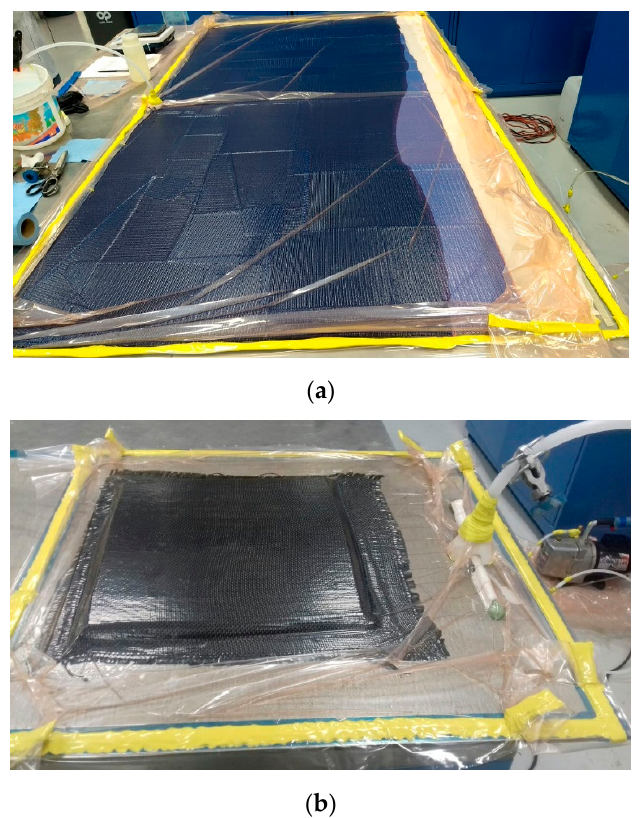
Figure 1. Vacuum Assisted Resin Infusion for ( a ) Carbon fiber reinforced plastic (CFRP) coupons and ( b ) example of CFRP-PVC foam core sandwich. ( b ) example of CFRP-PVC foam core